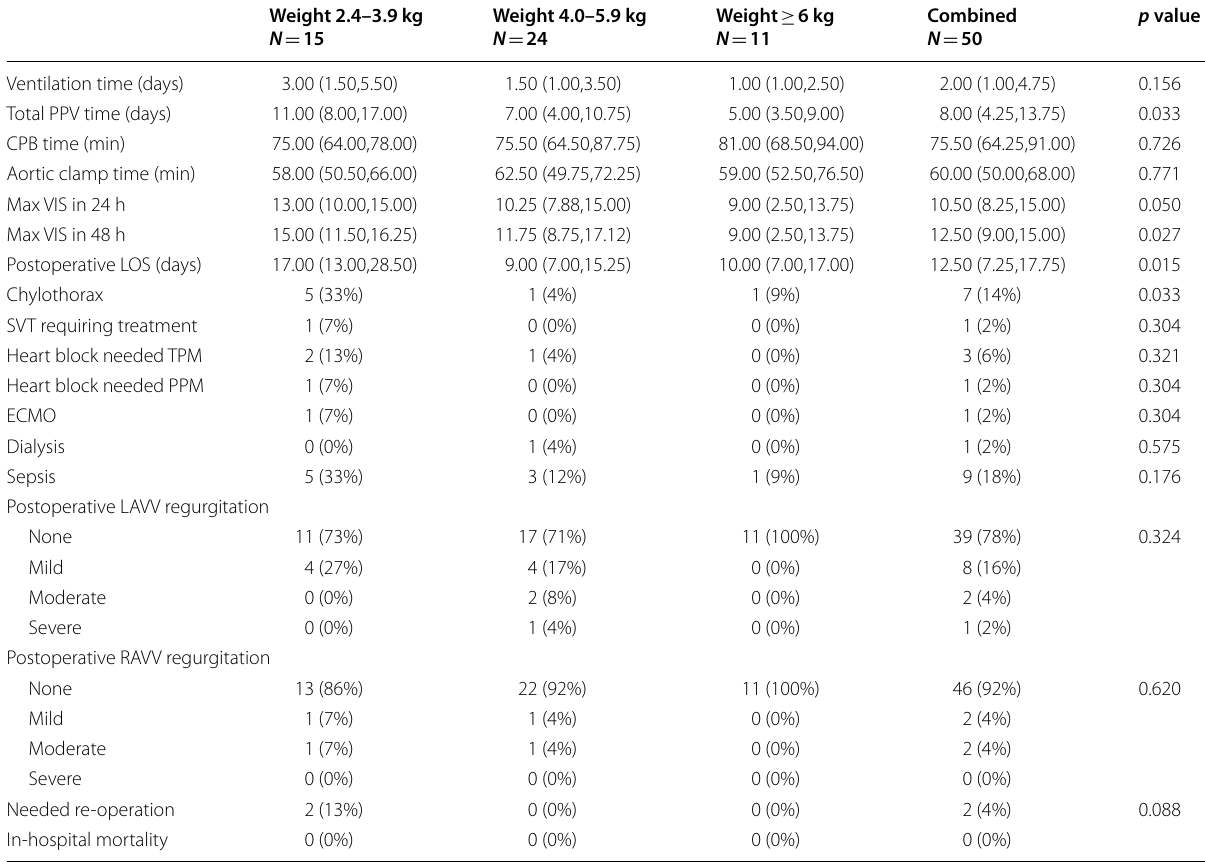
Table 2 Outcomes by weight group